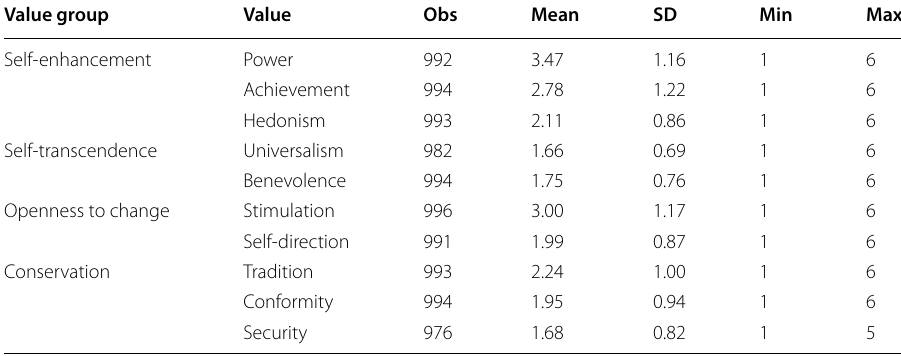
Table 2 Schwartz portraits variables: descriptive statistics Value